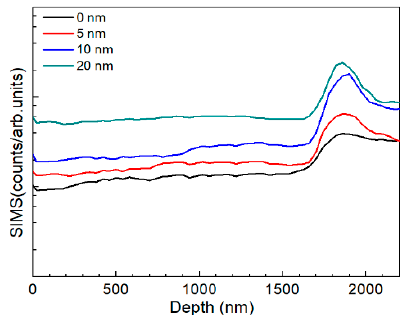
Figure 11. SIMS sodium profile as a function of Na 2 Se thickness.